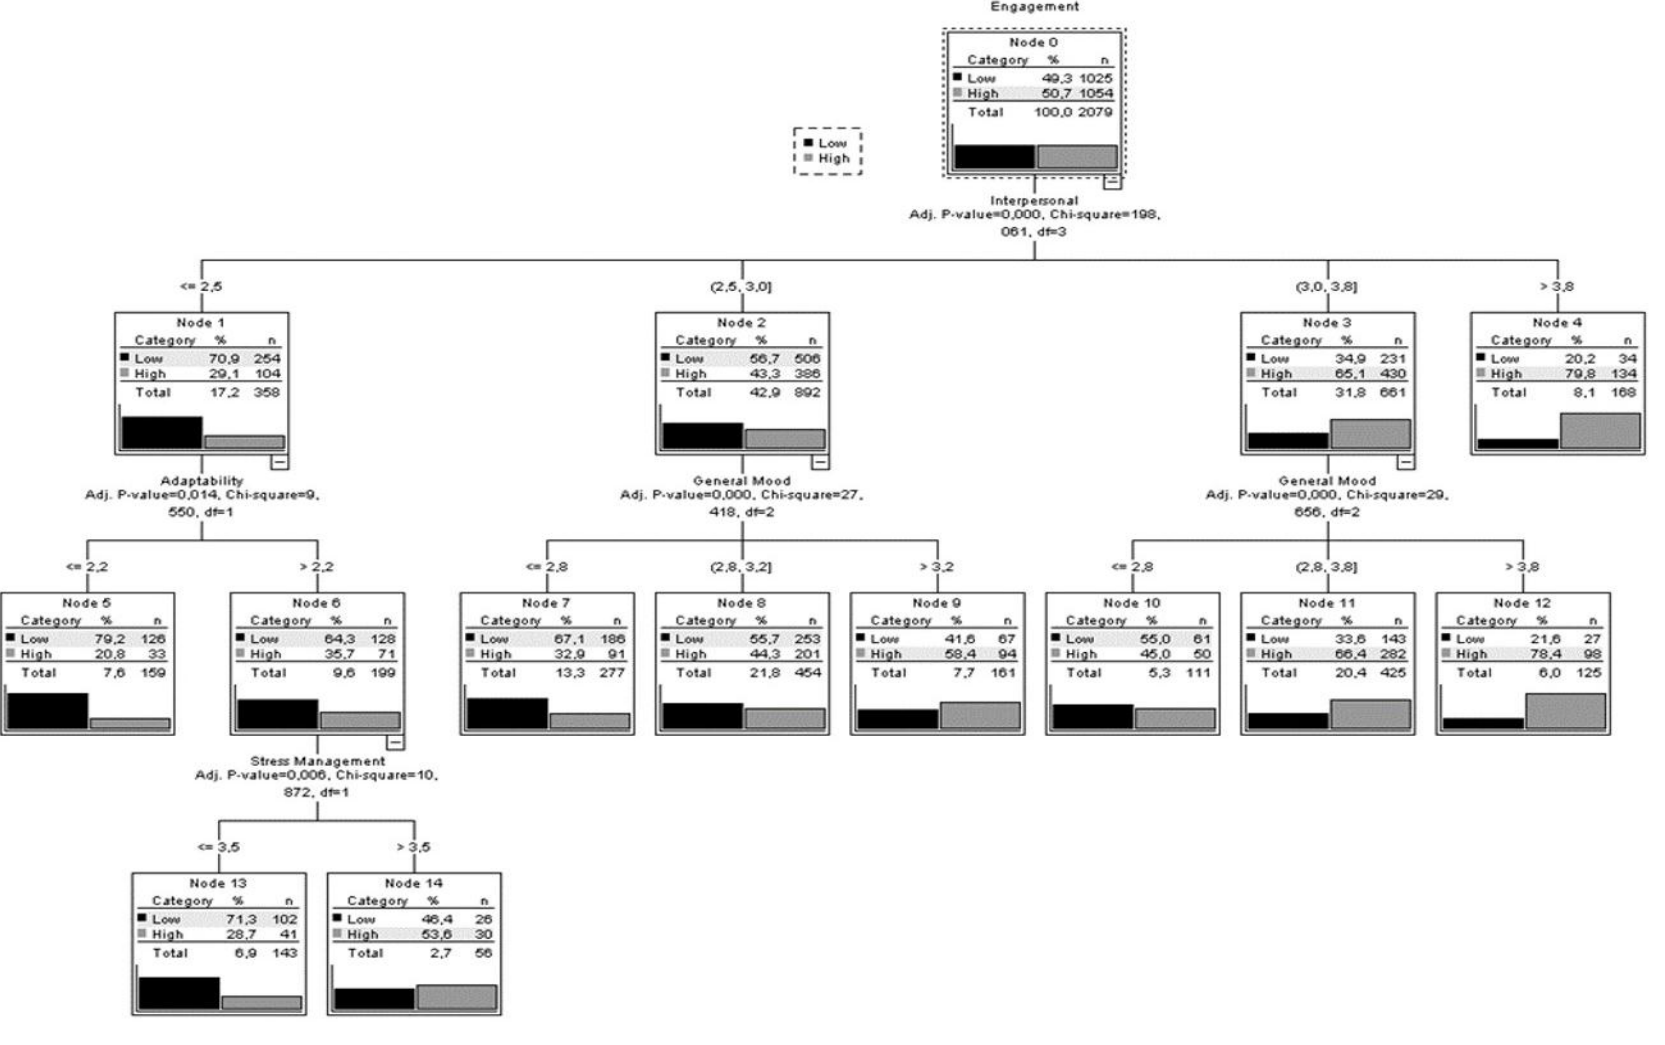
Figure 1. Regression and classification tree for engagement.